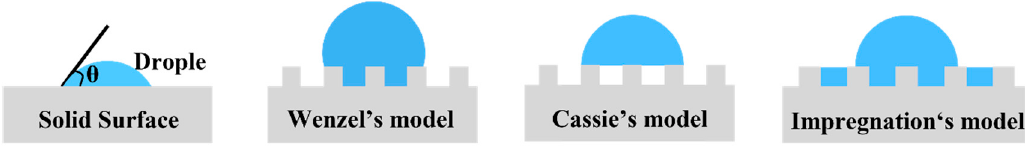
Figure 6. Diagram of the contact angle and wetting model.